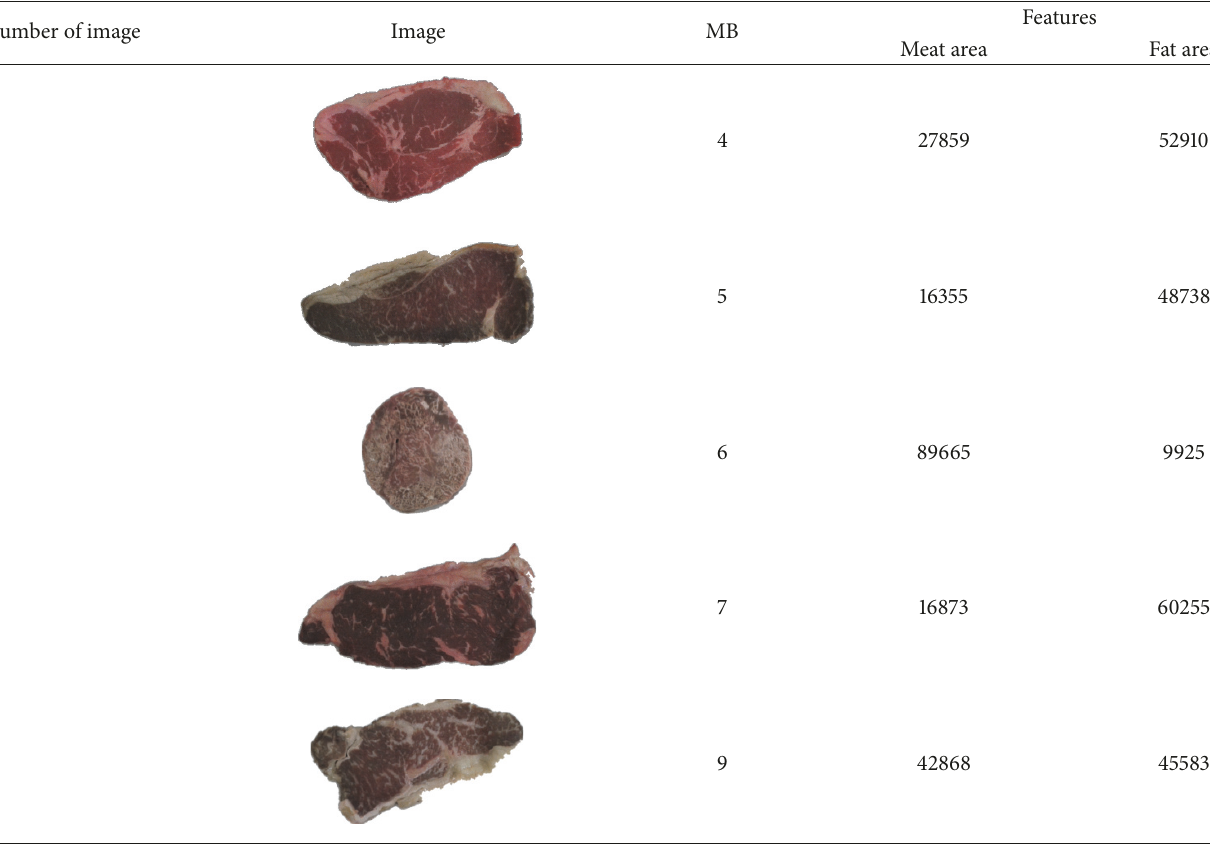
Table 2: Samples of features extraction.